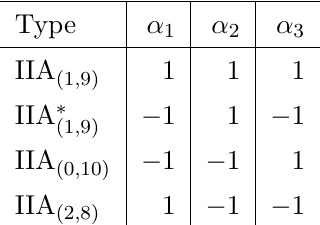
Table 14 . Relative signs for kinetic terms in ten-dimensional type-IIA theories. A plus sign corresponds to a standard kinetic term in Lorentz signature, as realized in IIA